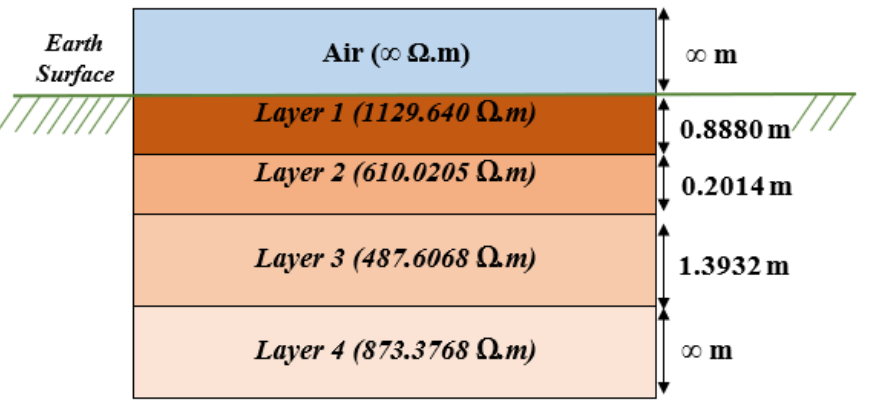
Figure 10. Soil profile interpretation for the Tower T50.